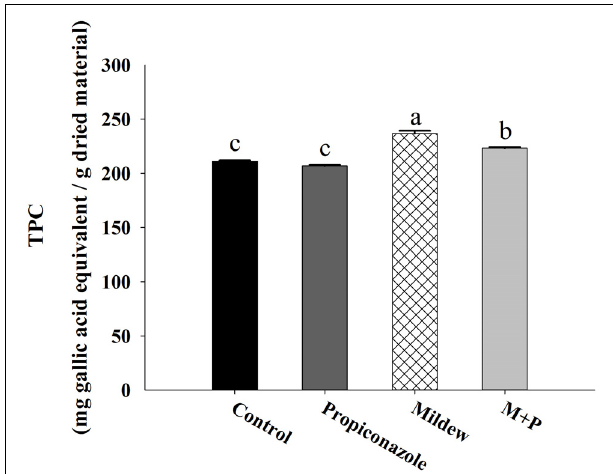
FIGURE 7 | The total phenolic content in the wheat leaves of four treaments. Different letters above the bars indicate significant difference among different treatments and the error bars is ± SE bars (15 biological replicates, P < 0.05, Tukey’s HSD